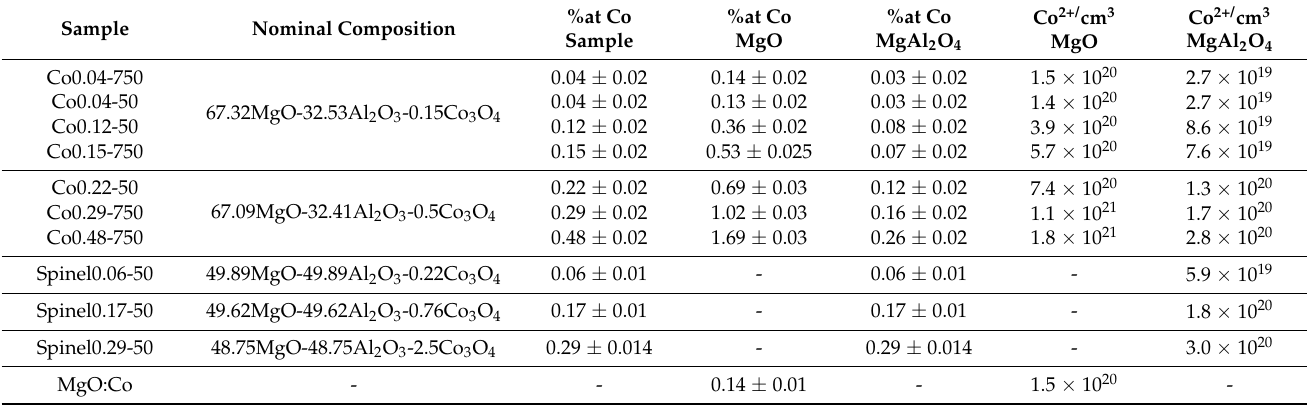
Table 1. Nominal composition (%mol) and composite-, MgO- and MgAl 2 O 4 - cobalt contents (% at) for all the samples. Atomic Co percentages were determined by EDS; Co 2+ ions/cm 3 in each phase were calculated using cobalt atomic content obtained by EDS and volume of MgO and MgAl 2 O 4 single crystal lattices. The atomic Co percentages are given relative to the total number of ions in the sample or phase, including oxide ions calculated by